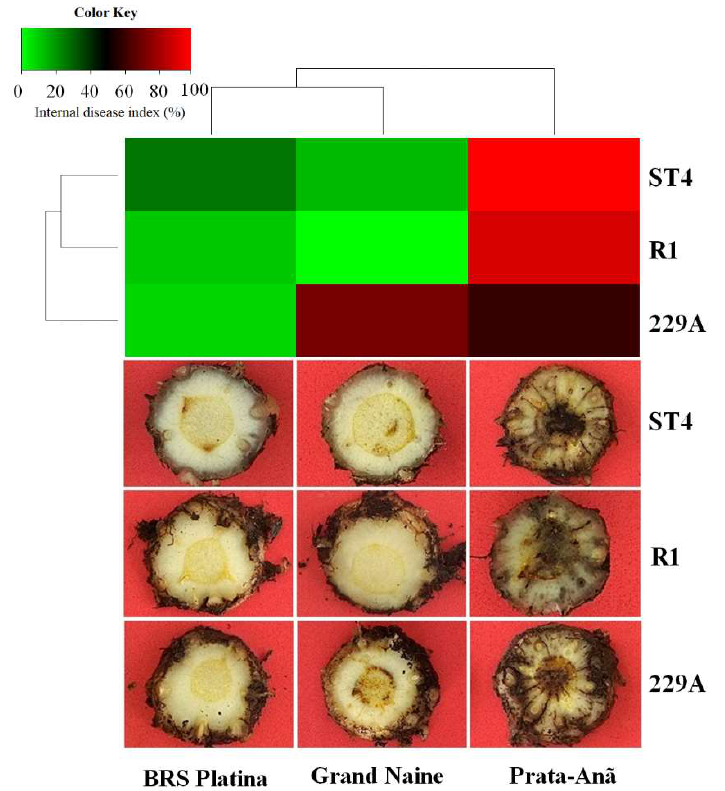
Figure 9. Heat map of internal symptom indices and cross-sections of the rhizomes of three banana cultivars 90 days after inoculation (DAI) with Fusarium oxysporum f. sp. cubense isolates that differ in virulence. The heat map colors reflect high levels of internal symptoms (intense red) and low levels of internal symptoms (intense green). The disease indices were calculated from the evaluation scores of 10 plants of each cultivar using the Dita et al. 2014 [80] rating scale. Foc: Fusarium oxysporum f.